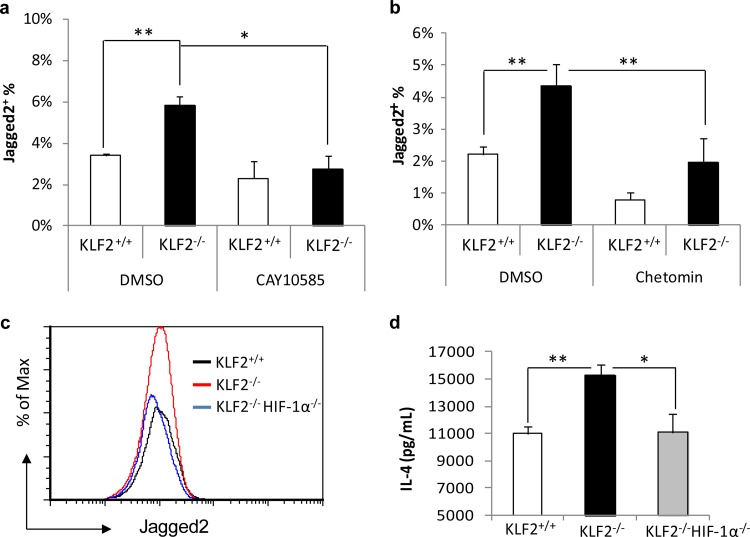
HIF-1α abrogated the induction of Jagged2+ population and Th2 by KLF2 deficiency. (a and b) Percentages of Jagged2+ cells in KLF2+/+ and KLF2−/− DCs in the presence or absence of HIF-1α inhibitor (CAY10585, 30 µM) (a) or p300–HIF-1α complex inhibitor (chetomin, 7.5 nM) (b) during the last 3 days of BMDC differentiation (2 experiments). (c) Relative percentages of Jagged2+ cells in KLF2+/+, KLF2−/−, and KLF2−/− HIF-1α−/− BMDCs. (d) IL-4 production by restimulated T cells after incubation with Jagged2− fraction of KLF2+/+, KLF2−/−, or KLF2−/− HIF-1α−/− BMDCs (with or without the addition of 5% Jagged2+ fraction) (2 experiments). *, P < 0.05, and **, P < 0.01, by two-way ANOVA. Data represent the mean results ± SEM.